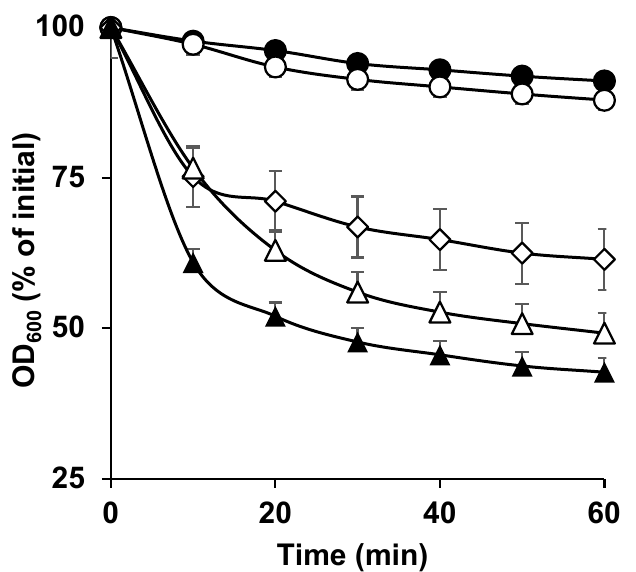
Figure 1. Germination of C. perfringens SM101 spores in the presence of DPA, Ca-DPA, and CaCl 2 . Heat-activated spores of strain SM101 were germinated for 60 min at 37 ◦ C in 25 mM Tris-HCl buffer (pH 6.0) (filled circles), 50 mM DPA (pH 6.0) (open circles), 50 mM Ca-DPA (pH 8.0) (open diamonds), 100 mM KCl (pH 6.0) (filled triangles), or 50 mM CaCl 2 (pH 6.0) (open triangles). Germination was determined by measuring the OD 600 and calculating the percent decrease compared with the initial values, as described in Section 2.3. Error bars are the standard deviations from the means of at least duplicate experiments with three independent spore preparations.